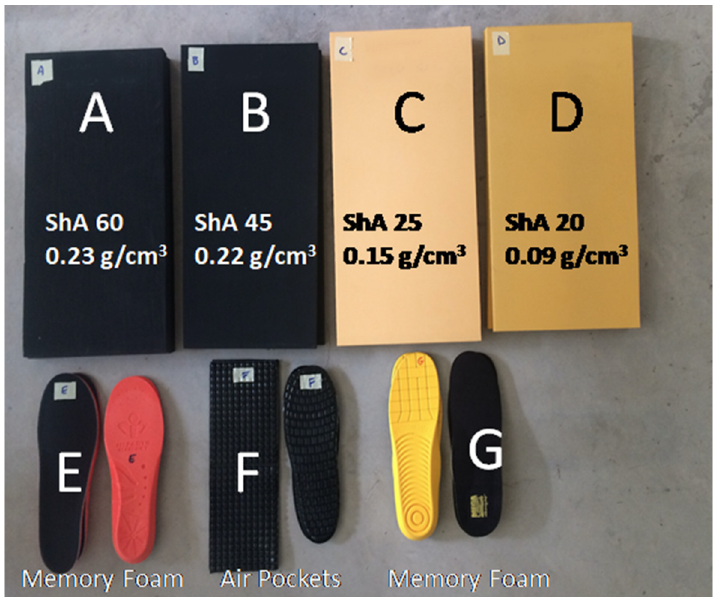
Figure 1. Outsole materials and insoles that were used in the tests described in this paper. Upper row: outsole materials; lower row: insoles.